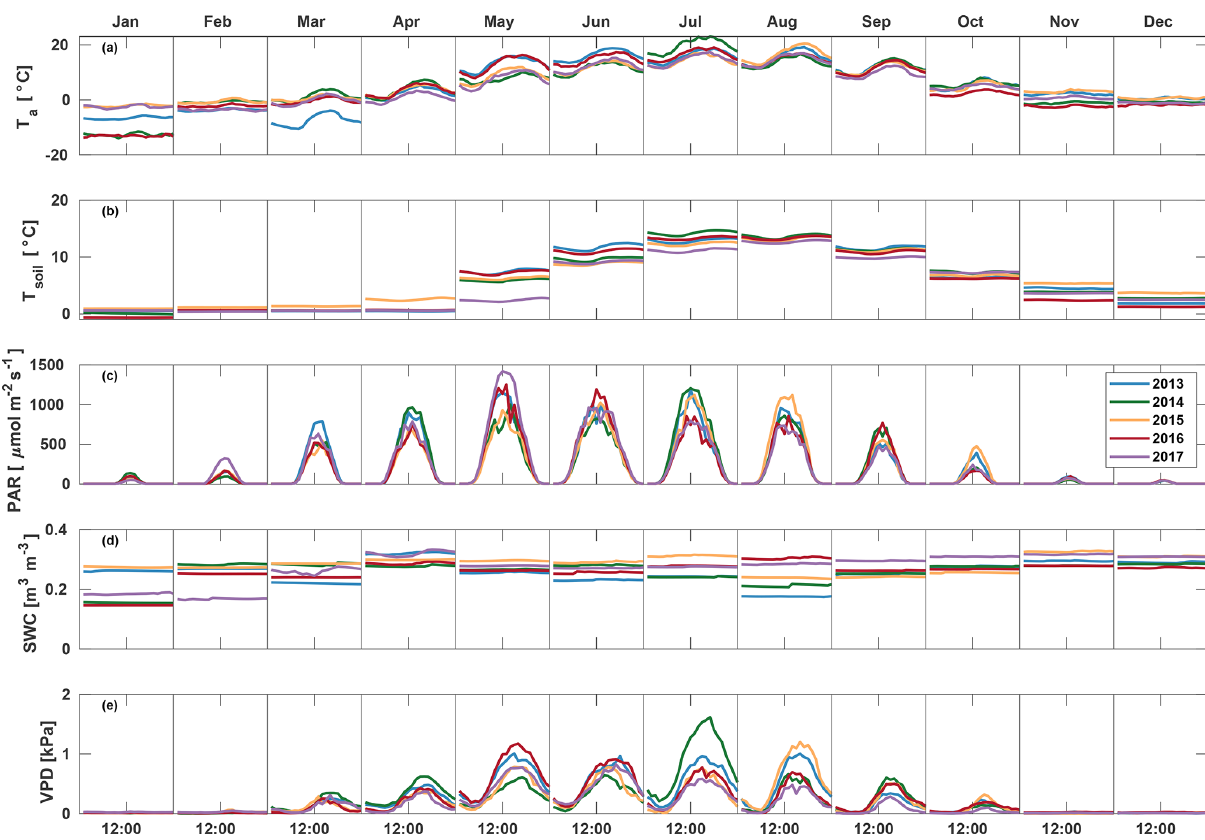
Figure 1. Median diurnal variation of T a , T soil , PAR, SWC, and VPD in different months during the measurement period 2013–2017.